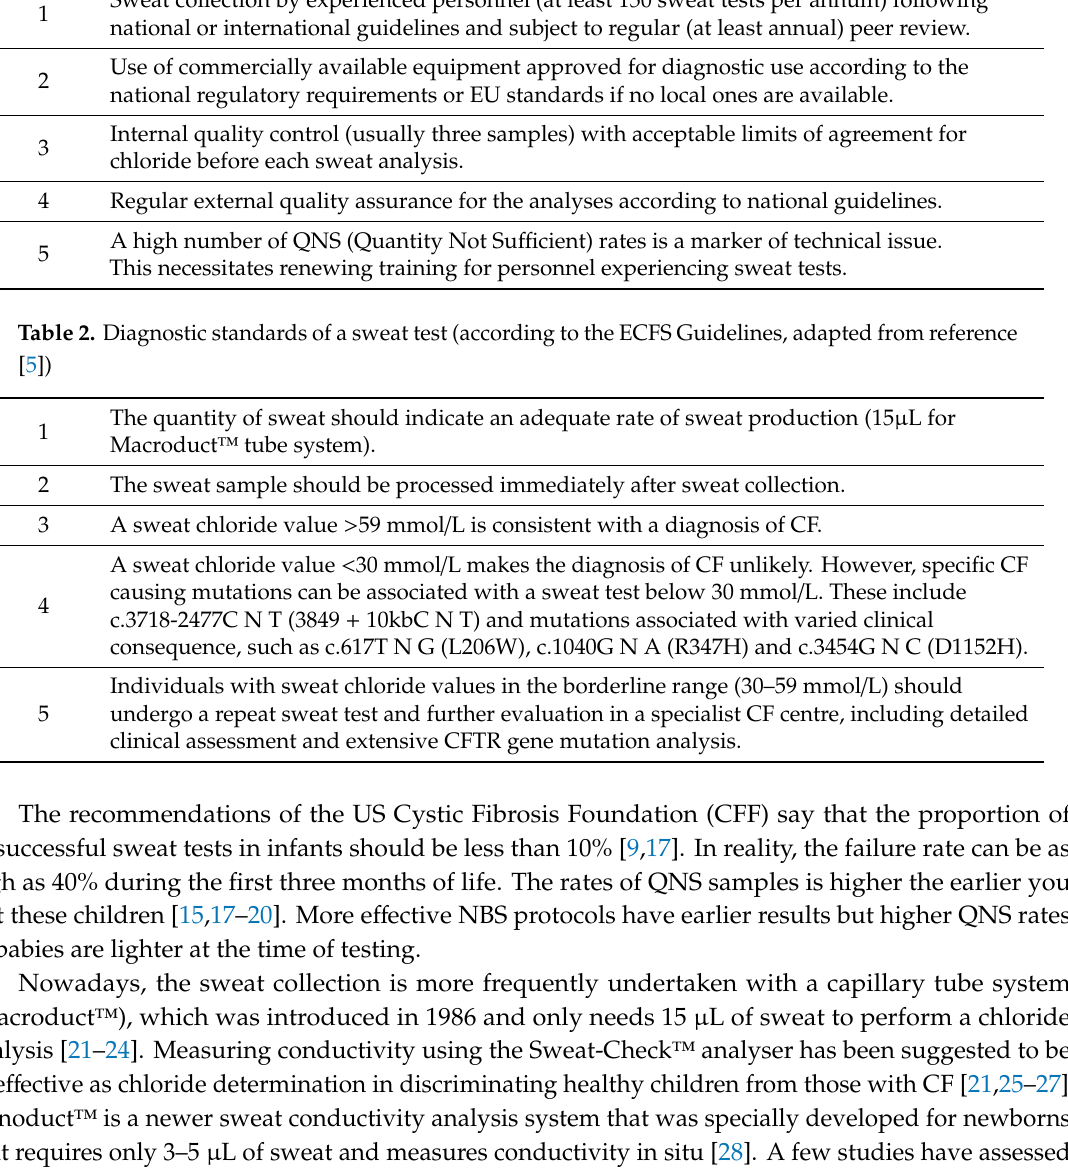
Table 1. Minimal standards for laboratories performing sweat tests (according to the ECFS Guidelines,